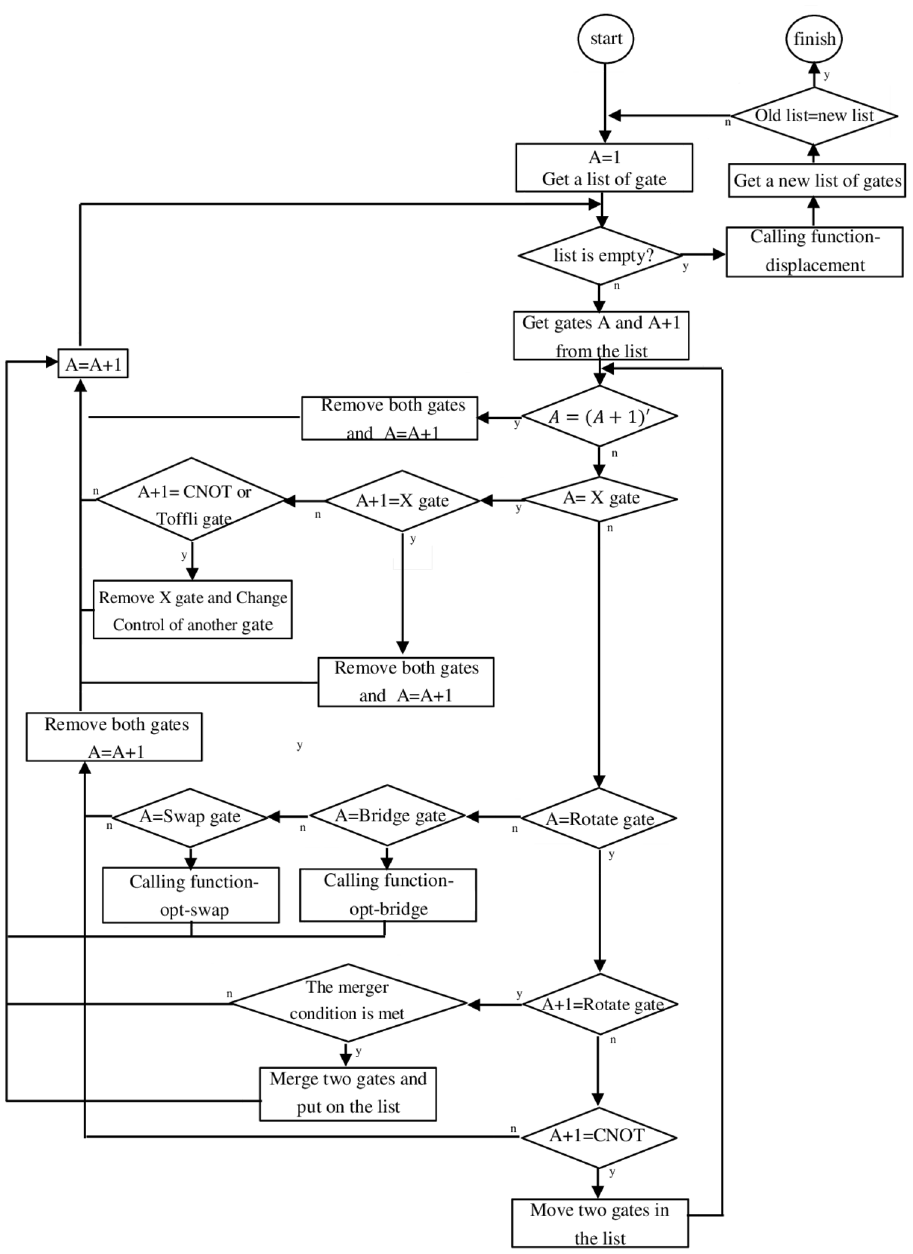
Figure 6. The flowchart of the steps of the optimization approach using rules